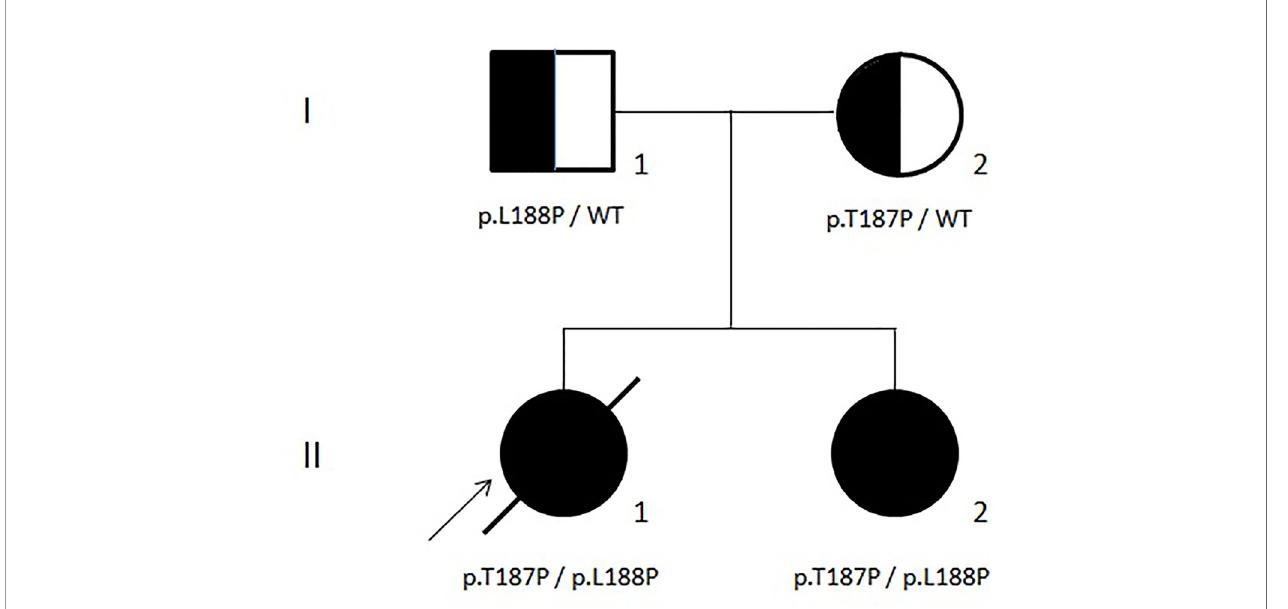
FIGURE 2 | Family